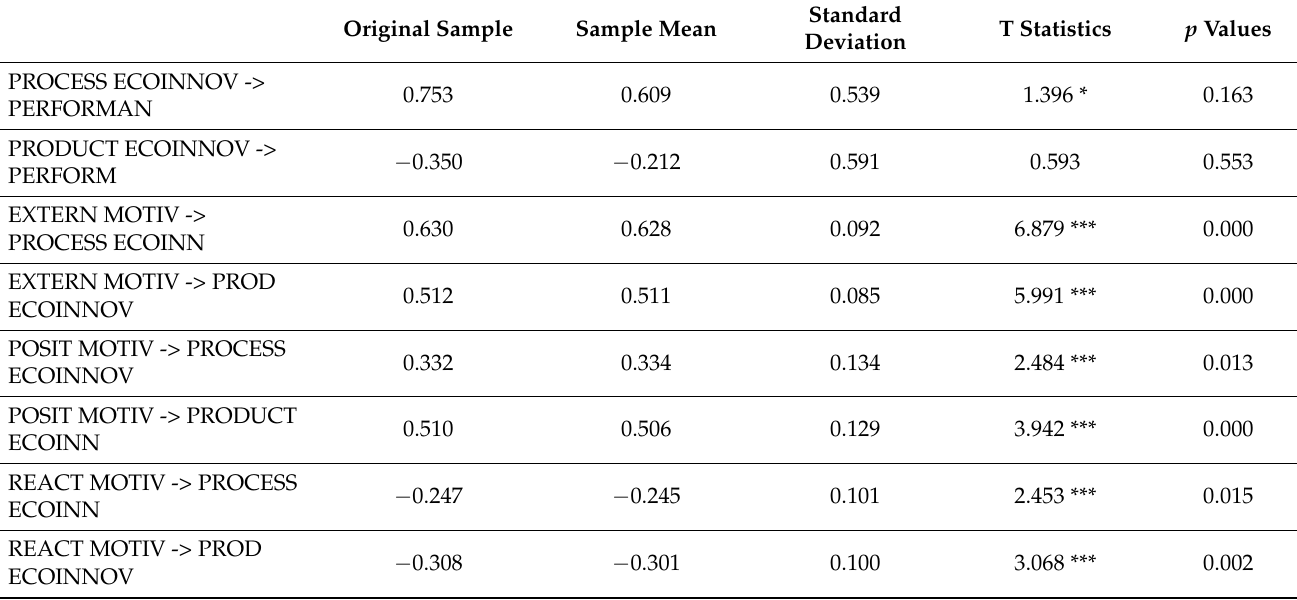
Table 4. Analysis of the significance of the structural